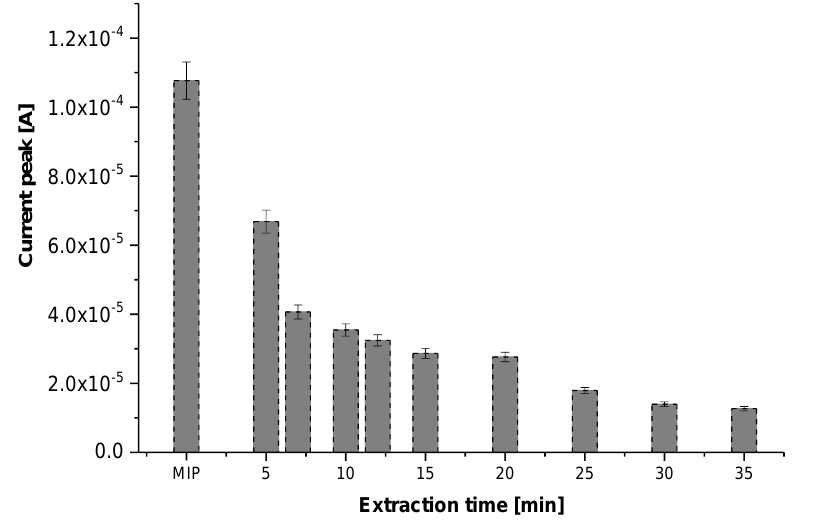
Figure 2. Follow-up of the peak current variation versus the extraction duration in methanol.